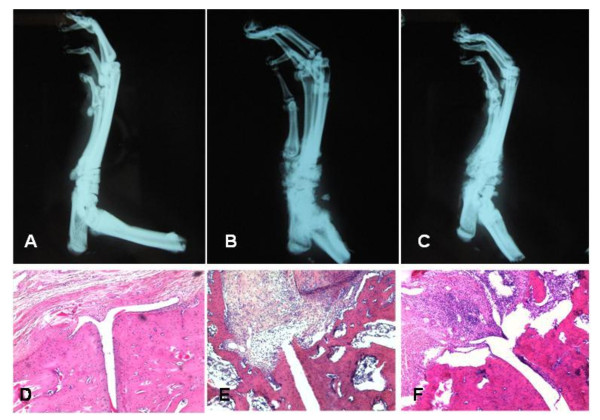
Radiographs and histological aspect of hind limbs at Day 21 after the onset of arthritis. Experiments were performed in controls rats (A, D), AIA rats (B, E) and nor-NOHA treated rats (C, F). On radiographs, both AIA and treated AIA rats exhibited a thickening of the soft tissues of the ankle and foot as well as a joint destruction and periosteal tissue neoformation. Histological slices were stained with HES (enlargement × 20). A severe joint destruction associated to synovial proliferation was present in AIA and treated AIA rats.